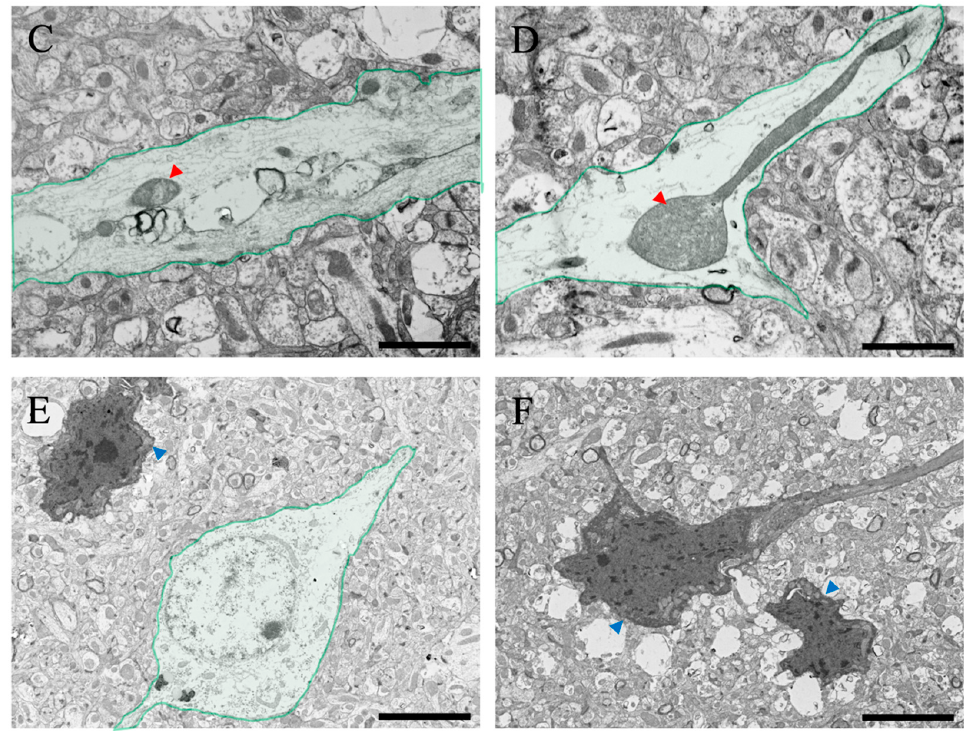
Figure 7. ( A – F ) Transmitted electron microscopic images of the cerebral cortical tissues from the ammonia-treated animals 24 h post-administration. Green-colored neurons in the cerebral cortex are shown. Black arrow in ( A ) indicates the intact perineuronal glial cell (astrocyte). Black arrowheads indicate the rough endoplasmic reticulum. Red arrowheads indicate degenerating mitochondria. Blue arrowheads indicate neuronal atrophy. Scale bars in ( A – D ) = 2 µm, and ( E , F ) = 5 µm.